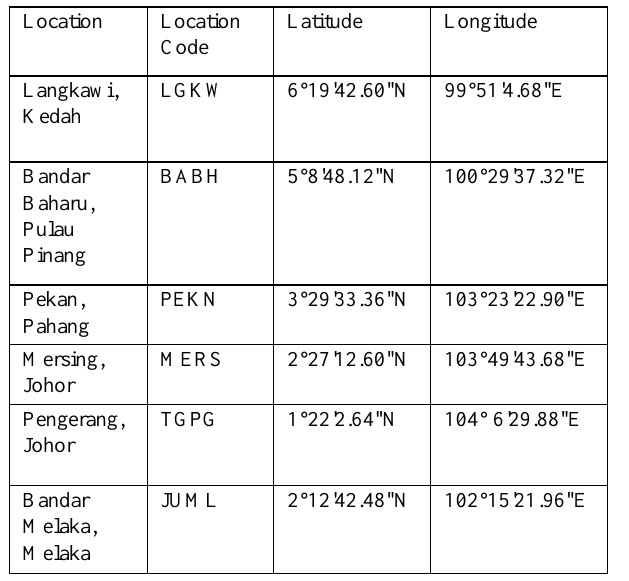
Table 2. MyRTKnet GPS receiver stations coordinate and code